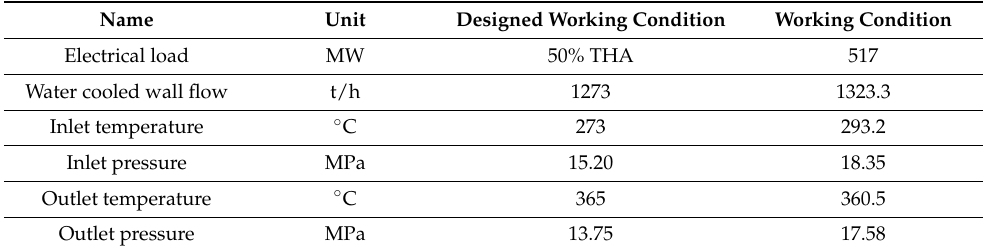
Table 2. Thermal parameters of water cooled wall